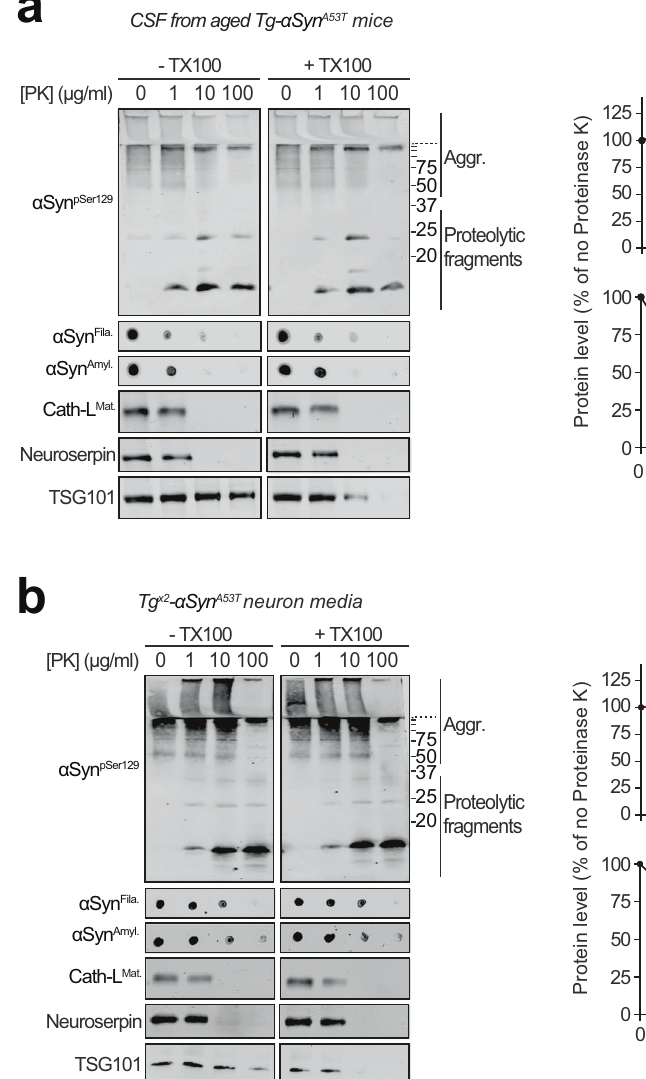
TSG101; n =4for α Syn pSer129 ,Cath-L Mat ). b MediacollectedfromTg x2 - α Syn A53T neuron cultures at DIV49 was subjected to limited proteolysis in presence or absence of 0.1%TritonX-100andanalyzedasin a ( n =3).Alldatarepresentmeans±SEM.Each ‘ n ’ is an independent collection (CSF or medium) and proteolysis experiment. n.s. not signi fi cant; * P <0.05; **** P <0.0001 by 2-way ANOVA with Bonferroni multiple comparisons post-test (compared at each PK